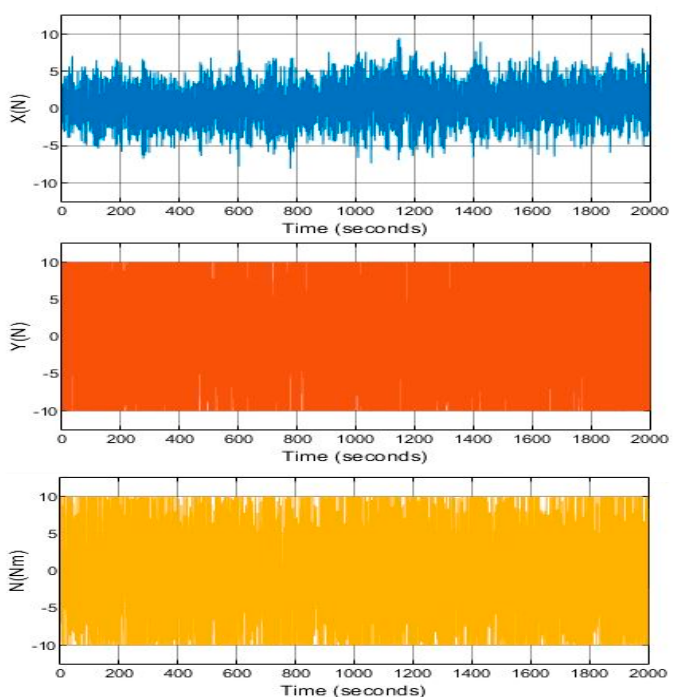
Figure 11. System with classical controller control result with waves. Force in X , Y and N .